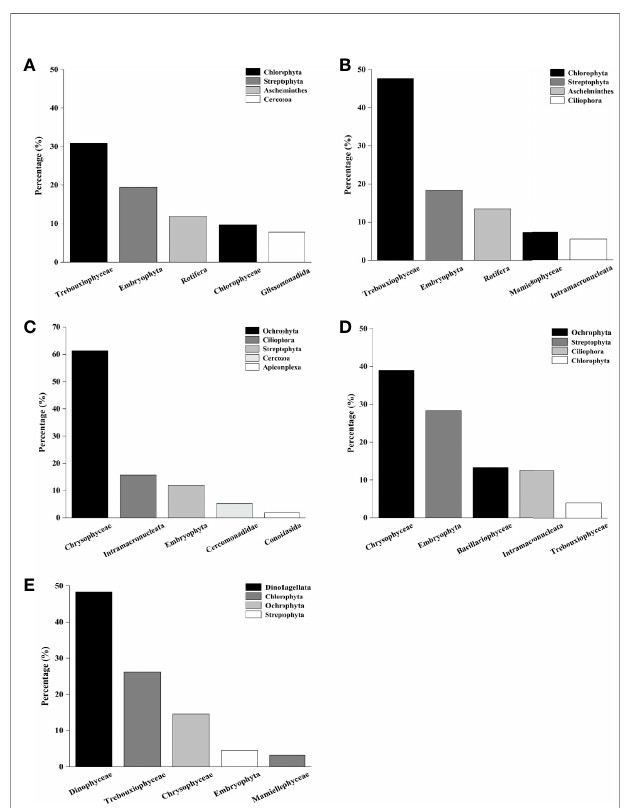
FIGURE 2 | Main eukaryote compositions of stomach contents of cultured organisms. (A) Main eukaryote compositions of stomach contents of P. trituberculatus in the PM system; (B) Main eukaryote compositions of stomach contents of M. japonicus in the PM system; (C) Main eukaryote compositions of stomach contents of P. trituberculatus in the PMS system; (D) Main eukaryote compositions of stomach contents of M. japonicus in the PMS system; (E) Main eukaryote compositions of stomach contents of S. constricta in the PMS